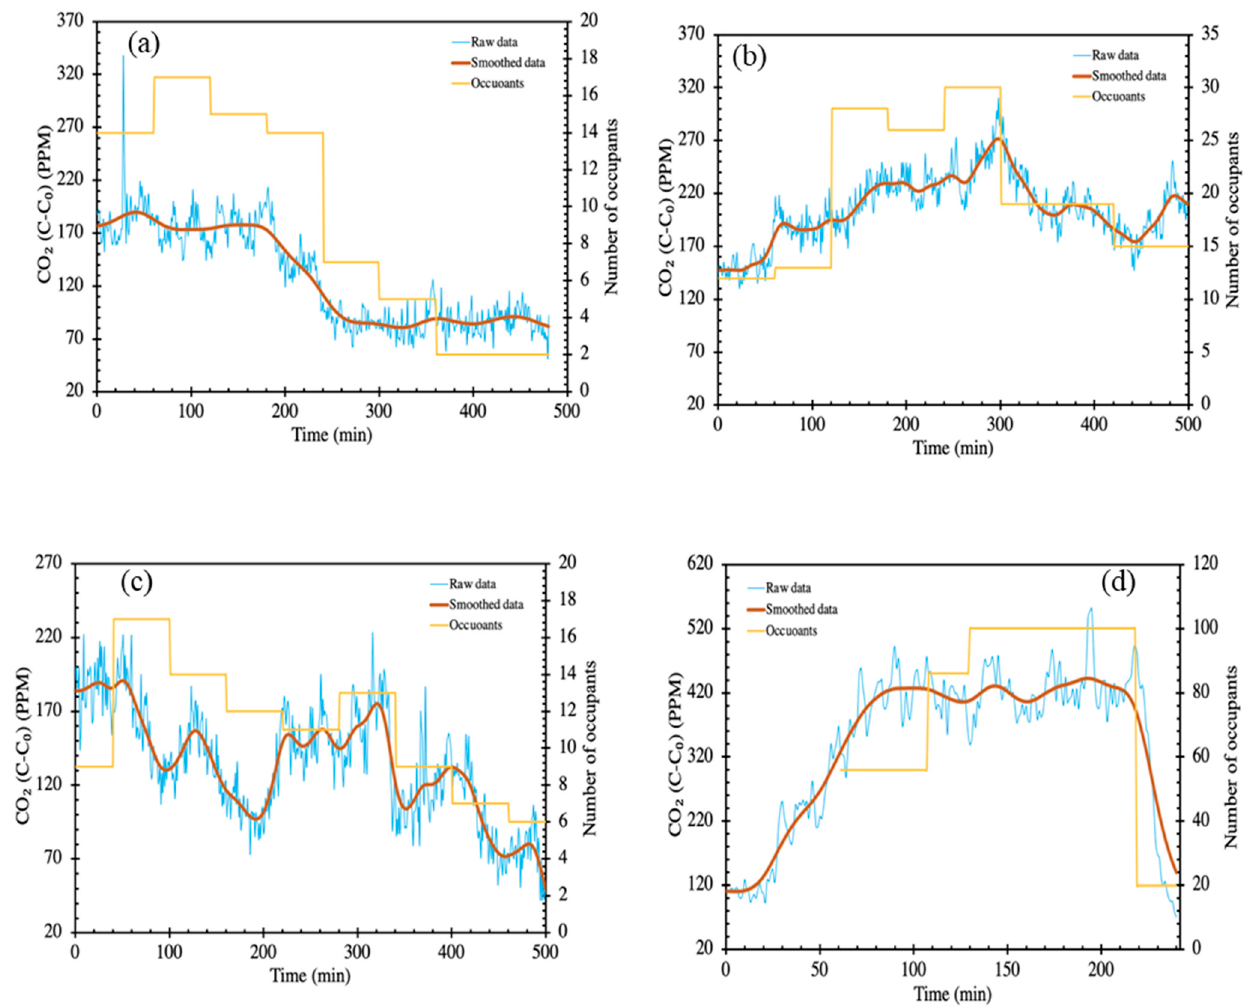
Figure 1. Schematic representation of raw and smoothened CO 2 data in ( a ) Hospital medical day unit (HS3-MDU); ( b ) Hospital emergency and outpatient waiting room (HS4-EOM); ( c ) Hospital outpatient waiting room (HS5-OPR); ( d ) Pub/restaurant (PR).